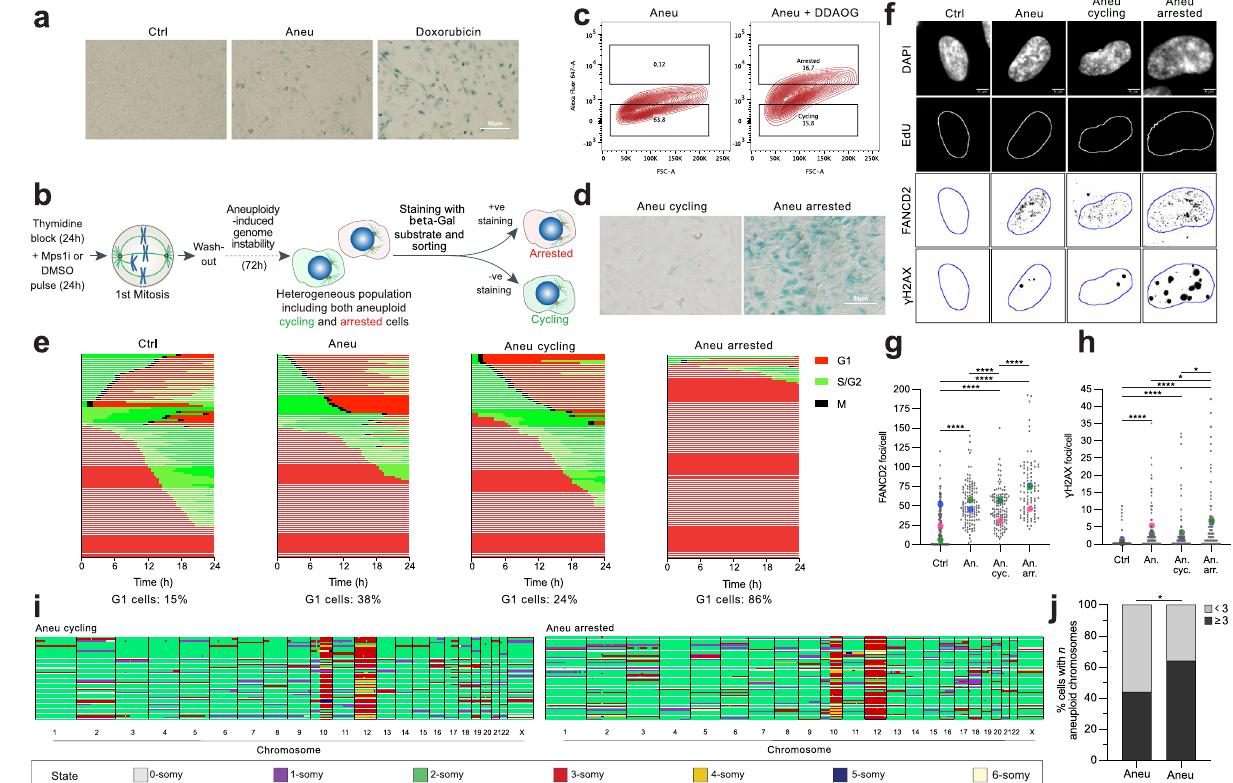
Fig. 5 | Aneuploid cells that retained their proliferative capacity exhibit reducedlevelsofDNAdamageandgenomeinstability.a Senescence-associated β -galactosidase staining in control and aneuploid cells. Doxorubicin-treated cells were used as a positive control. N =3 independent experiments. b Experimental work fl owforamethodtoseparateandrecoverbothcyclingandarrestedaneuploid cells based on FACS-sorting and the usage of a fl uorescent substrate of the b-galactosidase enzyme. c FACS pro fi les showing the percentage of DDAOG- positive cells in aneuploid cells incubated or not with the DDAOG substrate. d Senescence-associated β -galactosidasestainingincyclingandarrestedaneuploid cells obtainedaftersorting. N =3 independentexperiments. e Cellcycle pro fi les of control,aneuploid,aneuploidcyclingand aneuploid arrested FUCCI-cellsanalyzed bylive-cellimagingandquanti fi cationofpercentageofG1cellsinthefoursamples ( n =100 for eachsample). Representative images( f ) and quanti fi cation of FANCD2 ( g ) and γ H2AX ( h ) foci per cell in the different samples. Only EdU negative cells were analyzed in order to exclude the contribution of S-phase cells present in the non-arrested cell samples ( n =123 for Ctrl, n =123 for Aneu, n =123 for Aneu cyc, n =89 for Aneu arr). In ( g ) and ( h ), **** indicates p <0,0001. In ( h ), * indicates p =0.0439 (Aneu vs Aneu cycling) or p =0.0123 (Aneu cycling vs Aneu